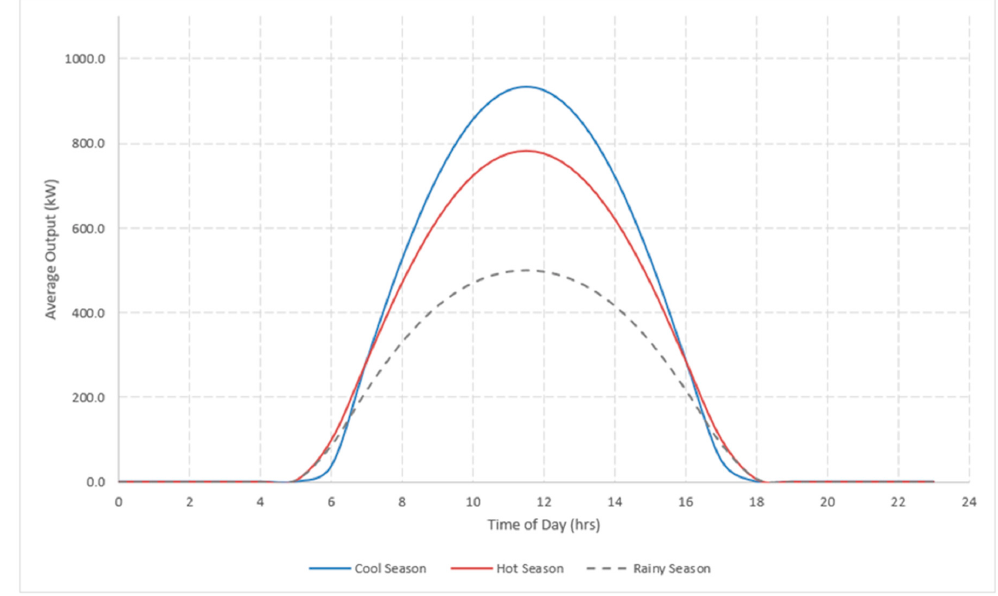
Figure 11. Averaged daily photovoltaic (PV) output profiles.